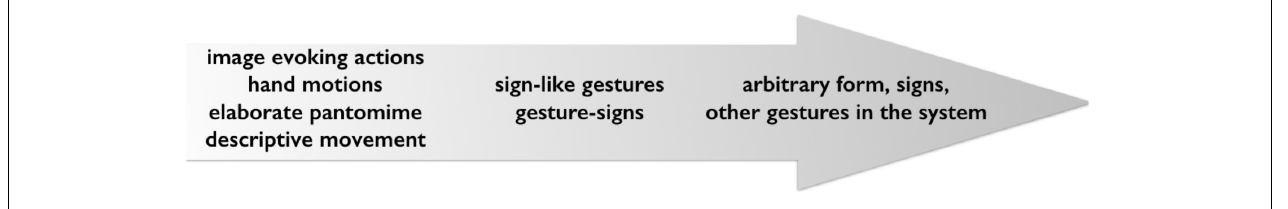
FIGURE 2 | Visible actions as utterances: phases of historical